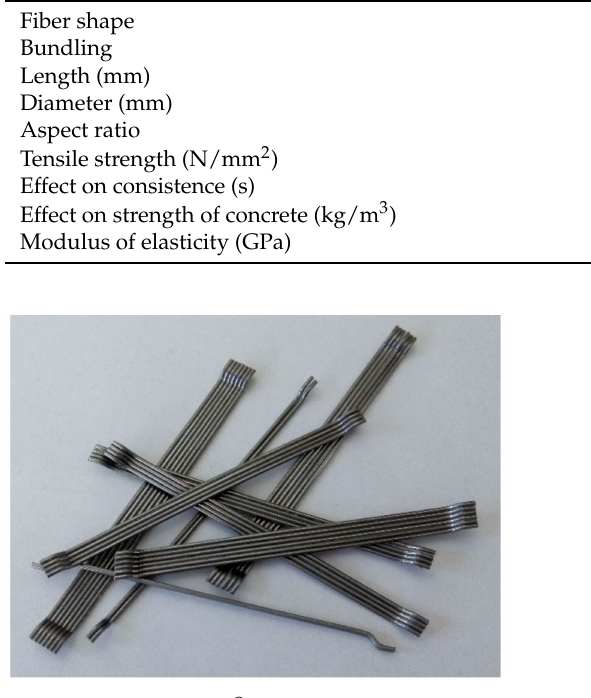
Figure 5. Fiber Dramix ® 3D 65/60